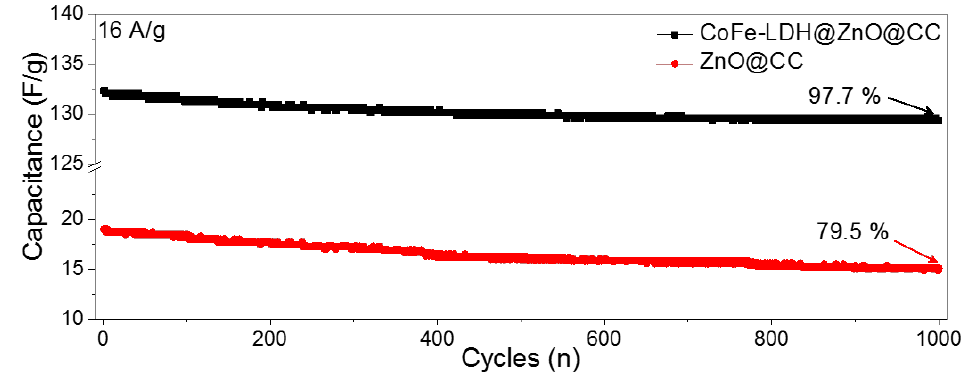
Figure 7. Cyclic stability of ZnO@CC and CoFe-LDH@ZnO@CC.